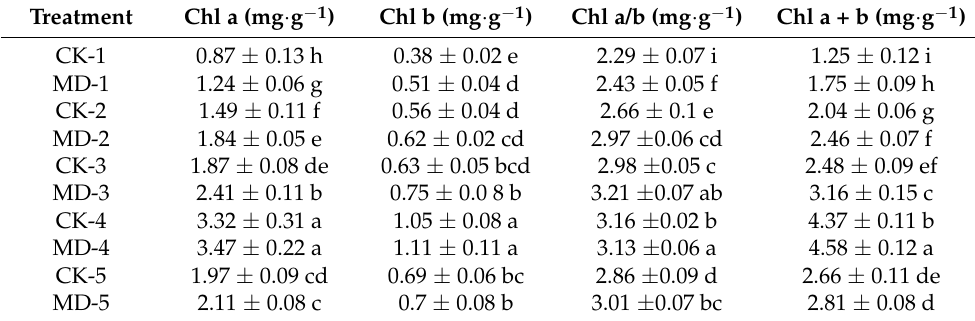
Table 4. Chlorophyll content of spinach under different treatments.